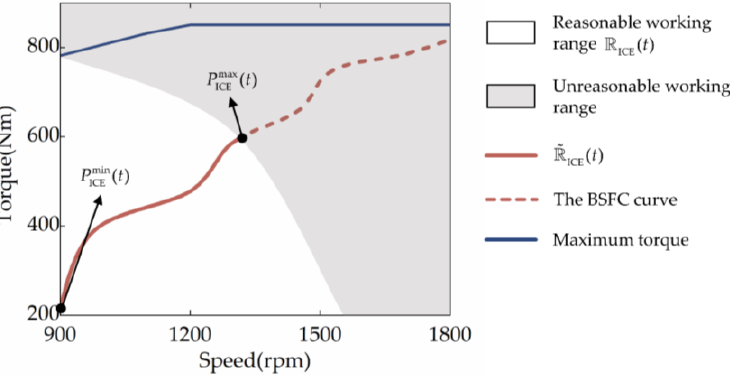
Figure 5. The reasonable working range of ICE.